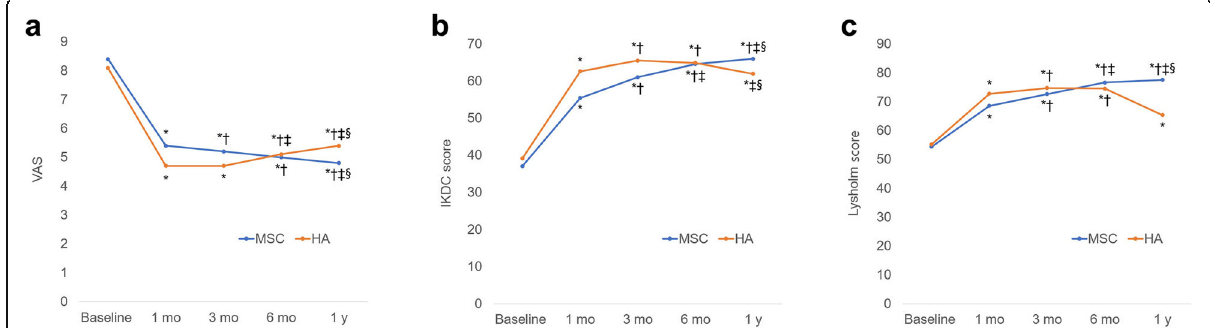
Fig. 2 Graphs demonstrating the changes in the a visual analog scale (VAS), b International Knee Documentation Committee (IKDC), and c Lysholm scores. Significantly different from * baseline, † 1-month follow-up, ‡ 3-month follow-up, § 6-month follow-up